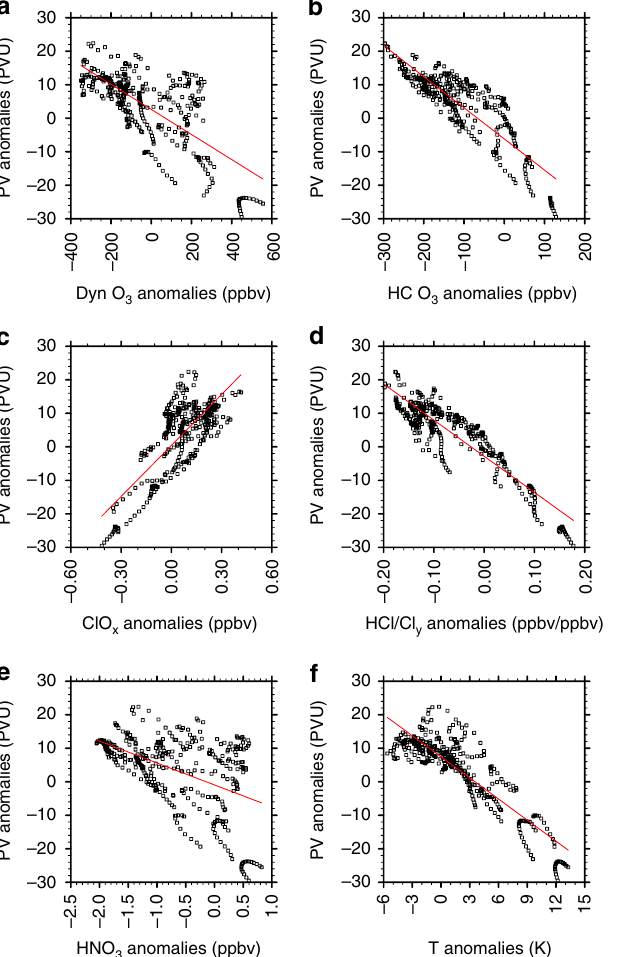
Fig. 4 Potential vorticity anomalies versus chemical variables and temperature anomalies inside the polar vortex. Scatter plots of February potential vorticity (PV) anomalies against a dynamical ozone, b heterogeneous chemical ozone, c ClO x , d HCl/Cl y ratio, e HNO 3 and f temperature anomalies within the polar vortex over the Eurasian continent in February during the three vortex-shift winters (i.e., 2001, 2008 and 2010). The red line represents the regression fi t